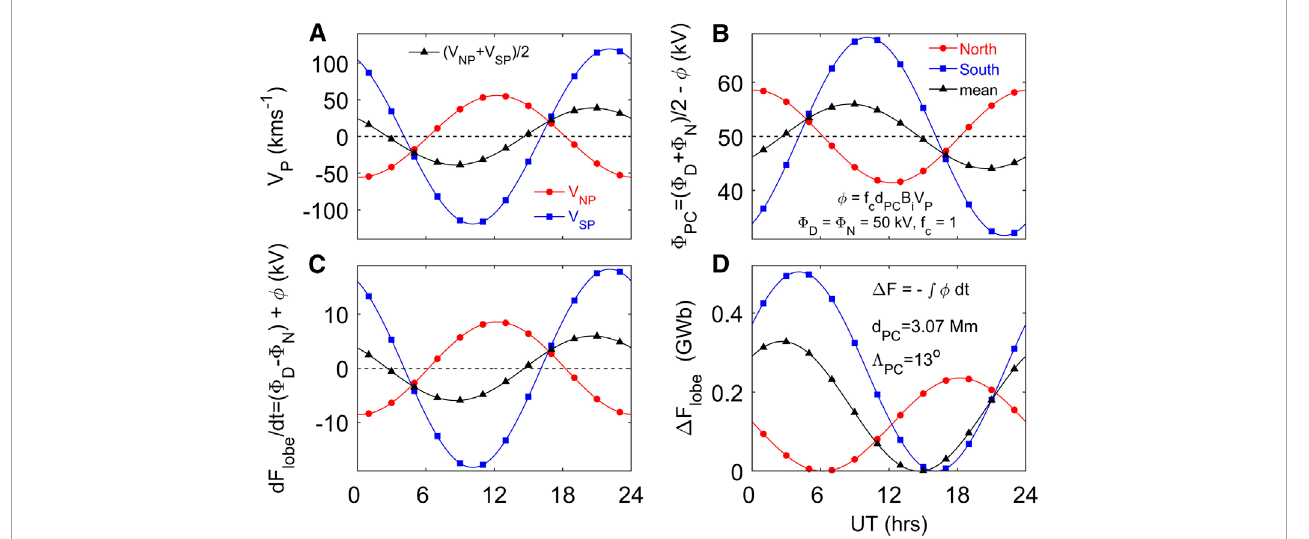
FIGURE 5 Analysis of the effect of pole motions in a geocentric-solar frame for a nominal polar cap diameter d PC of 3100 km , computed using the eccentric dipole field model of Koochak and Fraser-Smith (2017) for the year 2016. (A) The sunward velocity V P , of the north ( V NP , in red with red circle sympols) and south ( V SP , in blue with blue square symbols) poles. The black line (with black triangle symbols) is the average of the two. (B) The corresponding variations in the transpolar voltages Φ PC due to the perturbation by pole motions ϕ = f c d PC B i V P . This example is for reconnection voltages in the dayside magnetopause ( Φ D ) and nightside cross tail current sheet ( Φ N ) of 50 kV and Φ PC = ( Φ D + Φ N )/ 2 − ϕ . The fraction of the voltage ϕ that is applied to the polar cap is here f c = 1. (C) The corresponding rate at which flux is added to the tail lobe dF lobe / dt = ( Φ D − Φ N )+ ϕ . (D) The integral flux Δ F added to the lobe with respect to the minimum of the diurnal cycle in each case. Δ F N (in red with red circle symbols) is added to the northern lobe with minimum at 0.47 h UT and maximum of 0.2 GWb at 12.47 h UT ; Δ F S (in blue with blue square symbols) is added to the southern lobe with minimum at 10.17 h UT and maximum of 0.49 GWb at 12.17 h UT ; the average of the two is Δ F M = (Δ F N +Δ F S )/ 2 (in black with black triangle symbols) has a minimum at 14.86 h UT and maximum of 0.34 GWb